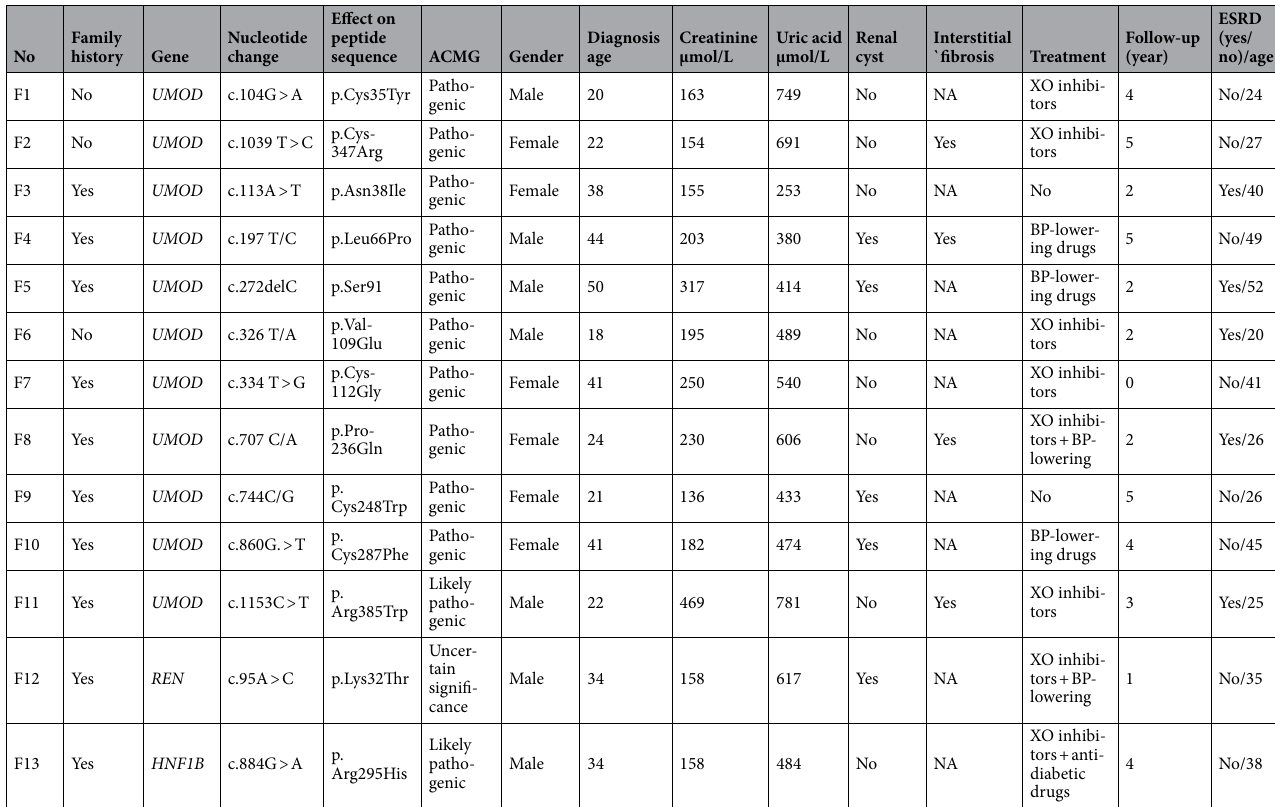
Table 2. Detected variants and corresponding clinical outcome. F family, NA not available, XO inhibitors xanthine oxidase inhibitor, allopurinol or febuxostat, BP-lowering drugs blood pressure lowering drugs, ESRD end stage renal